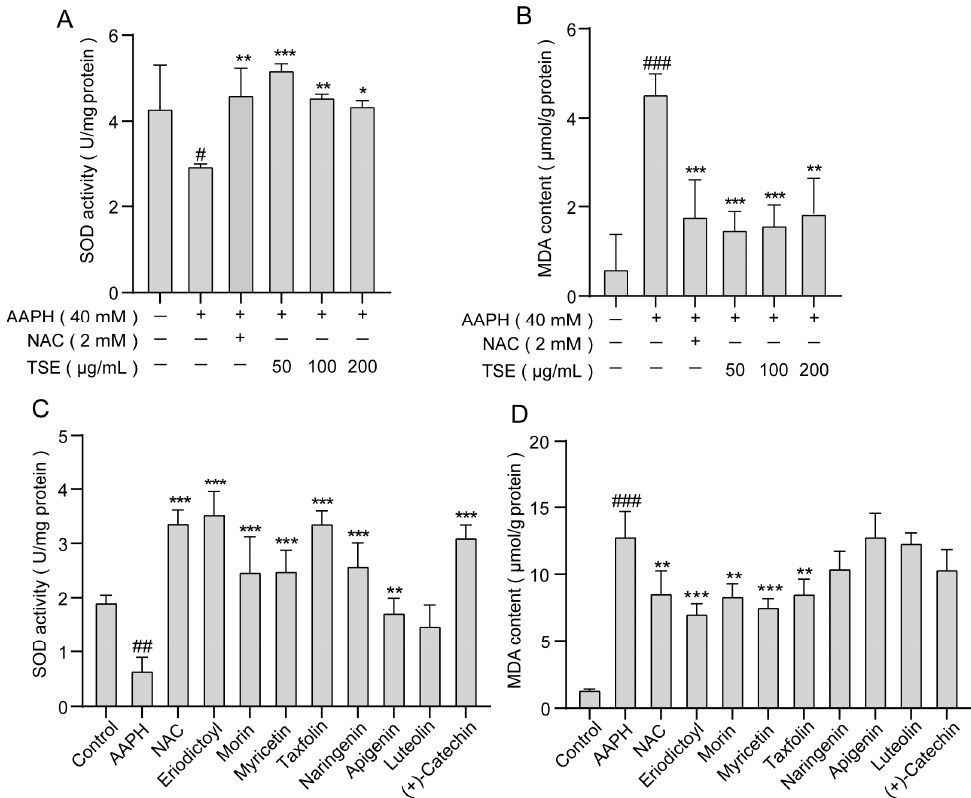
Figure 6. Effects of TSE and its flavonoids on the SOD activity and MDA content in the AAPH-treated ATDC5 cells. ( A , B ) The SOD activity and MDA content in ATDC5 cells treated with the TSE for 2 h, and co-incubated with 40 mM AAPH for 1 h. n = 3. ( C , D ) The SOD activity and MDA content in ATDC5 cells treated with eight flavonoids for 2 h, and co-incubated with 40 mM AAPH for 1 h. n = 3. NAC (2 mM) acts as a positive control. Data were expressed as mean ± SD and the statistical differences were analyzed by one-way ANOVA followed by LSD multiple comparisons test (IBM SPSS Statistics 25.0, Armonk, NY, USA). # p < 0.05, ## p < 0.01, ### p < 0.001 vs. the control group. * p < 0.05, ** p < 0.01, *** p < 0.001 vs. AAPH group.